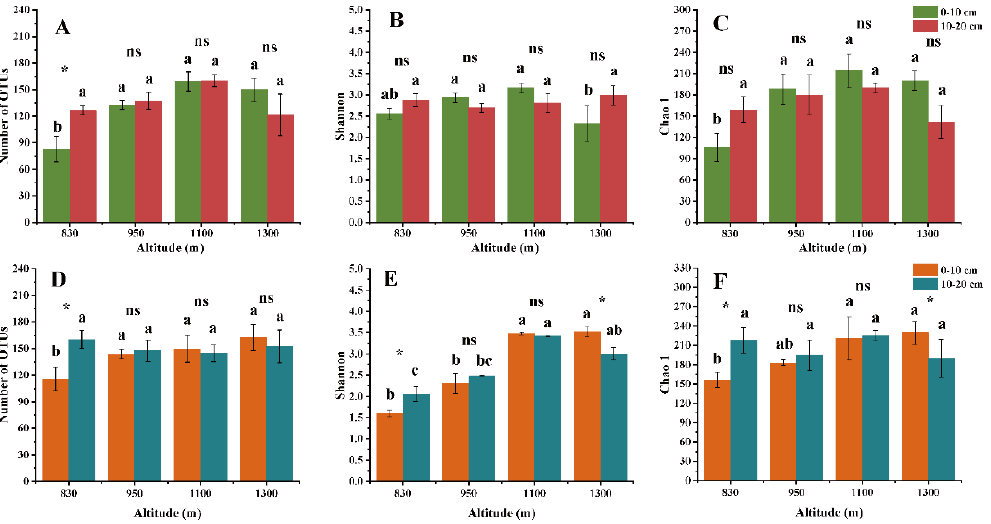
Figure 2. Observed number of OTUs, Shannon and Chao 1 indices of EcM ( A – C ) and SAP ( D – F ) fungal communities along the altitudinal gradient. ( A , D ) Observed number of OTUs; ( B , E ) Shannon index; ( C , F ) Chao 1 index. Different lowercase letters represent significant differences according to Tukey’s HSD test at different altitudes in the same soil layer ( p < 0.05). Symbols indicate significant differences according to the Student’s T test between different soil layers at the same altitude. ns, not significant; *, p <